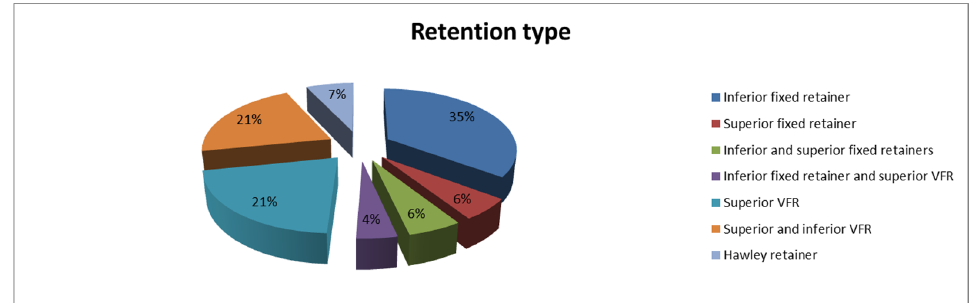
Figure 7. Gingival recession, male group.